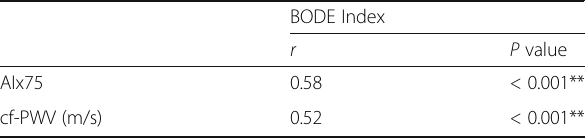
Table 4 Correlation between BODE index, AIx75 and cf-PWV